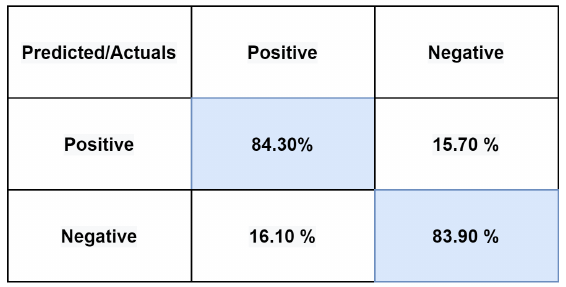
Figure 7. Confusion matrix of CNN-LSTM Roman Urdu sentiment analysis with RUSA